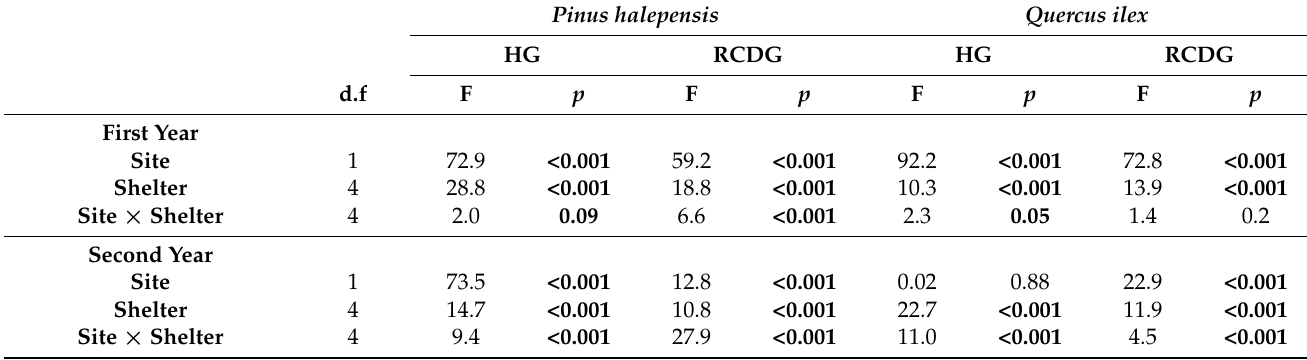
Table 4. Analysis of variance of root collar diameter (RCDG) and height (HG) absolute growth for each of the two studied species at the end of the first (November 2010) and second (November 2011) years after planting. Degrees of freedom (d.f.). F-statistic (F) and p -values ( p ) are shown for each of the two factors and their interaction. Significant effects are highlighted in